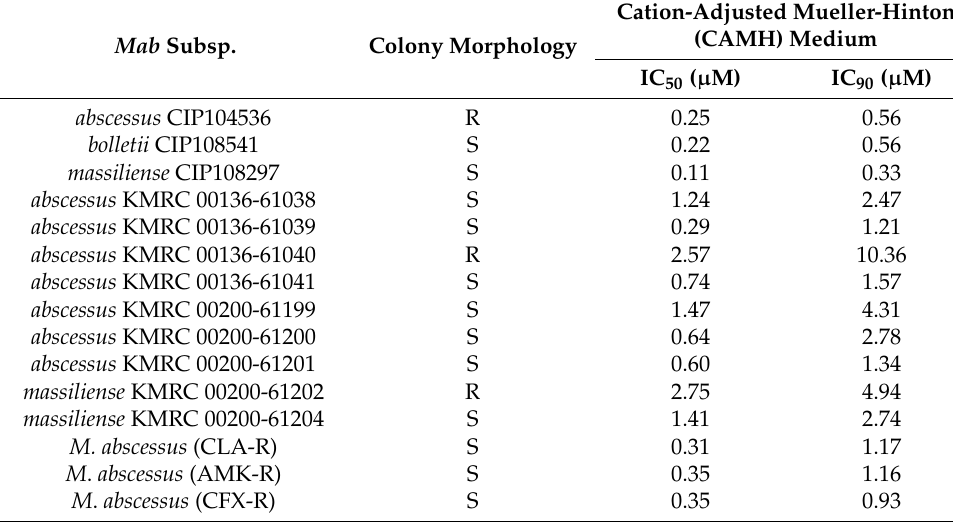
Table 2. Inhibitory potency of ETB against Mab subspecies, clinical isolates, and drug resistant Mab strains. Cation-Adjusted Mueller-Hinton (CAMH) Medium Mab Subsp. Colony Morphology IC 50 ( µ M) IC 90 ( µ M) abscessus CIP104536 R 0.25 0.56 bolletii CIP108541 S 0.22 0.56 massiliense CIP108297 0.11